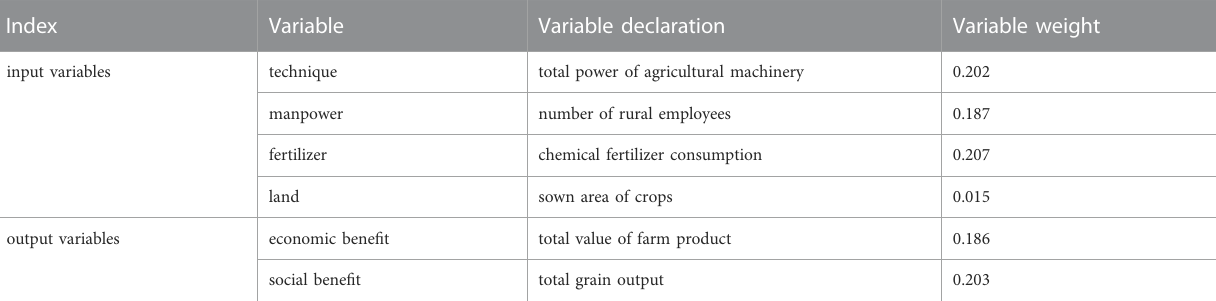
TABLE 2 Cultivated land use intensity evaluation index